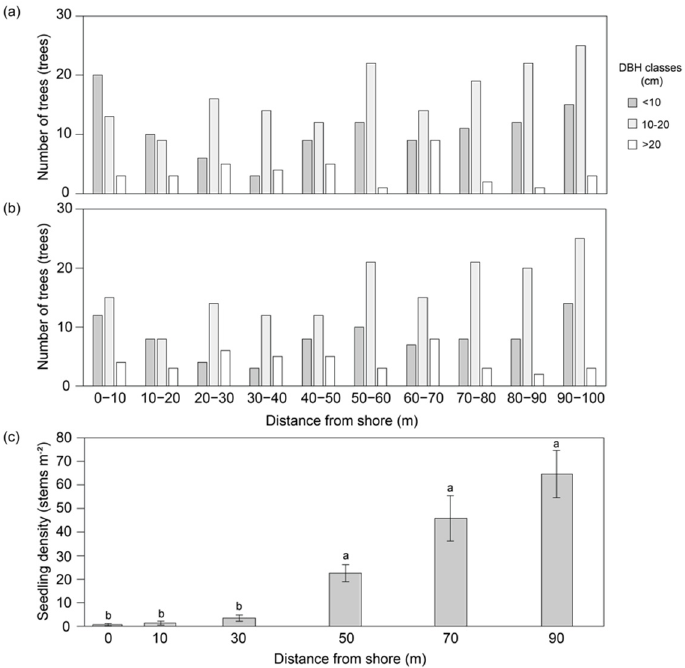
Figure 4. Distribution of DBH classes of A. alba trees in the belt transects in September 2020 ( a ) and October 2021 ( b ) and the density of A. alba seedlings (mean ± SE) across the transects from September 2020 to September 2021 ( c ). Different letters indicate significant differences (Kruskal–Wallis, p < 0.05) based on a post hoc test (pairwise comparison).